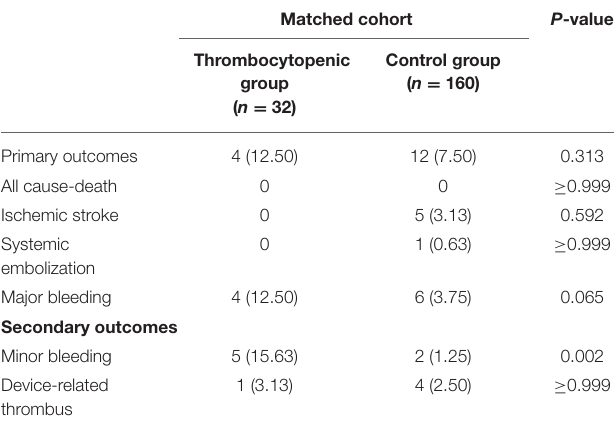
TABLE 3 | Clinical outcomes after